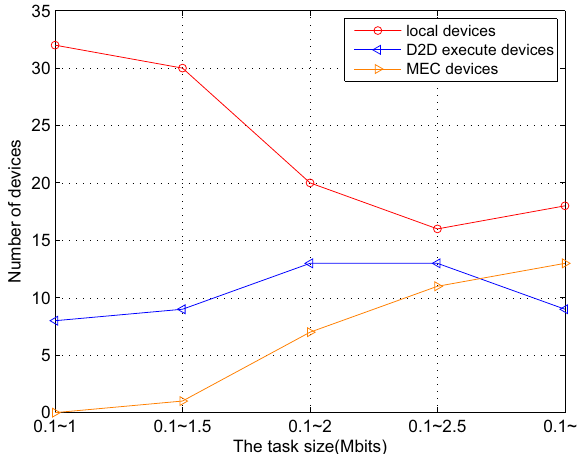
Figure 7. The number of devices versus the task size of different